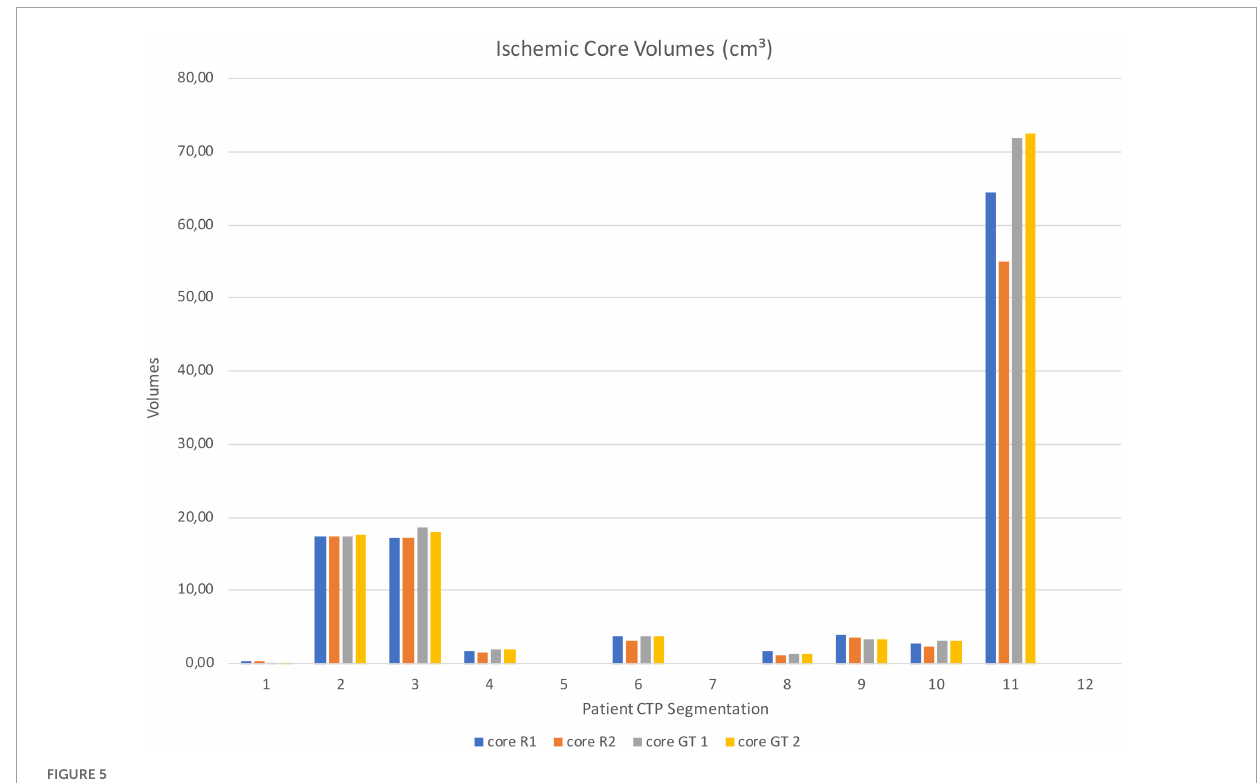
FIGURE5 Test sample ischemic core segmentation volumes from Rater 1 (R1), Rater 2 (R2), GT 1 and GT 2.